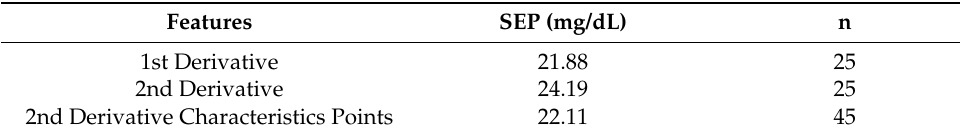
Table 5. Comparison of performances of different RFR models.